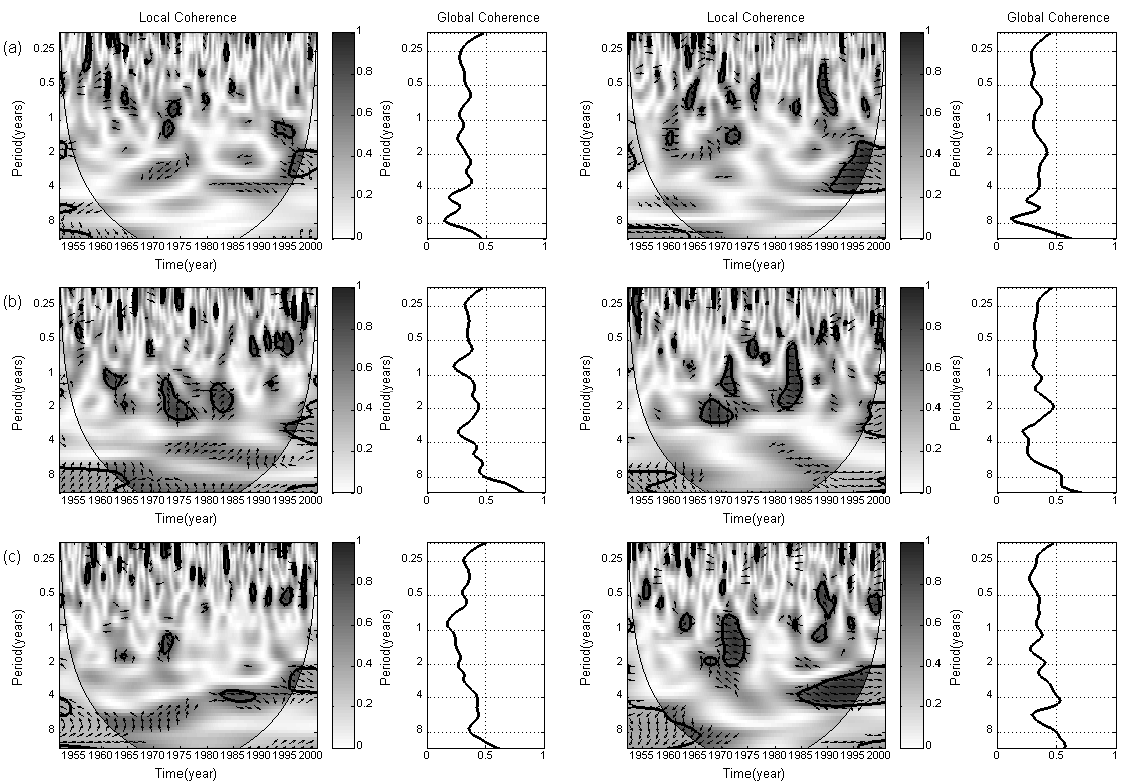
Fig. 8. (a) Squared wavelet coherence (local and global) between the first mode runoff and ENSO time series (left panel), and between the first mode runoff and IOD time series (right panel). The 5% significance level against red noise is shown as a thick contour and the cone of influence (COI) where edge effects might become important is shown as a thin black line. The relative phase relationship is shown as arrows (with in-phase pointing right, anti-phase pointing left, runoff leading ENSO by 90° pointing straight down, and ENSO leading runoff pointing straight up). (b) Same as (a) but for the second model of runoff. (c) Same as (a) but for the third model of runoff.